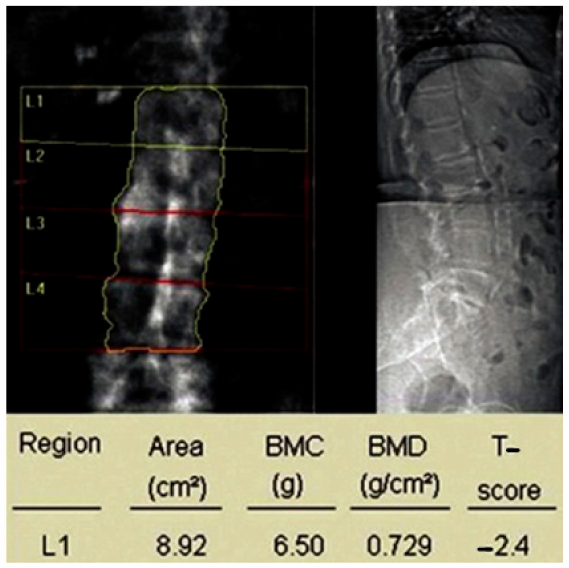
Figure 5. Bone mineral density measured and reported on one vertebra L1